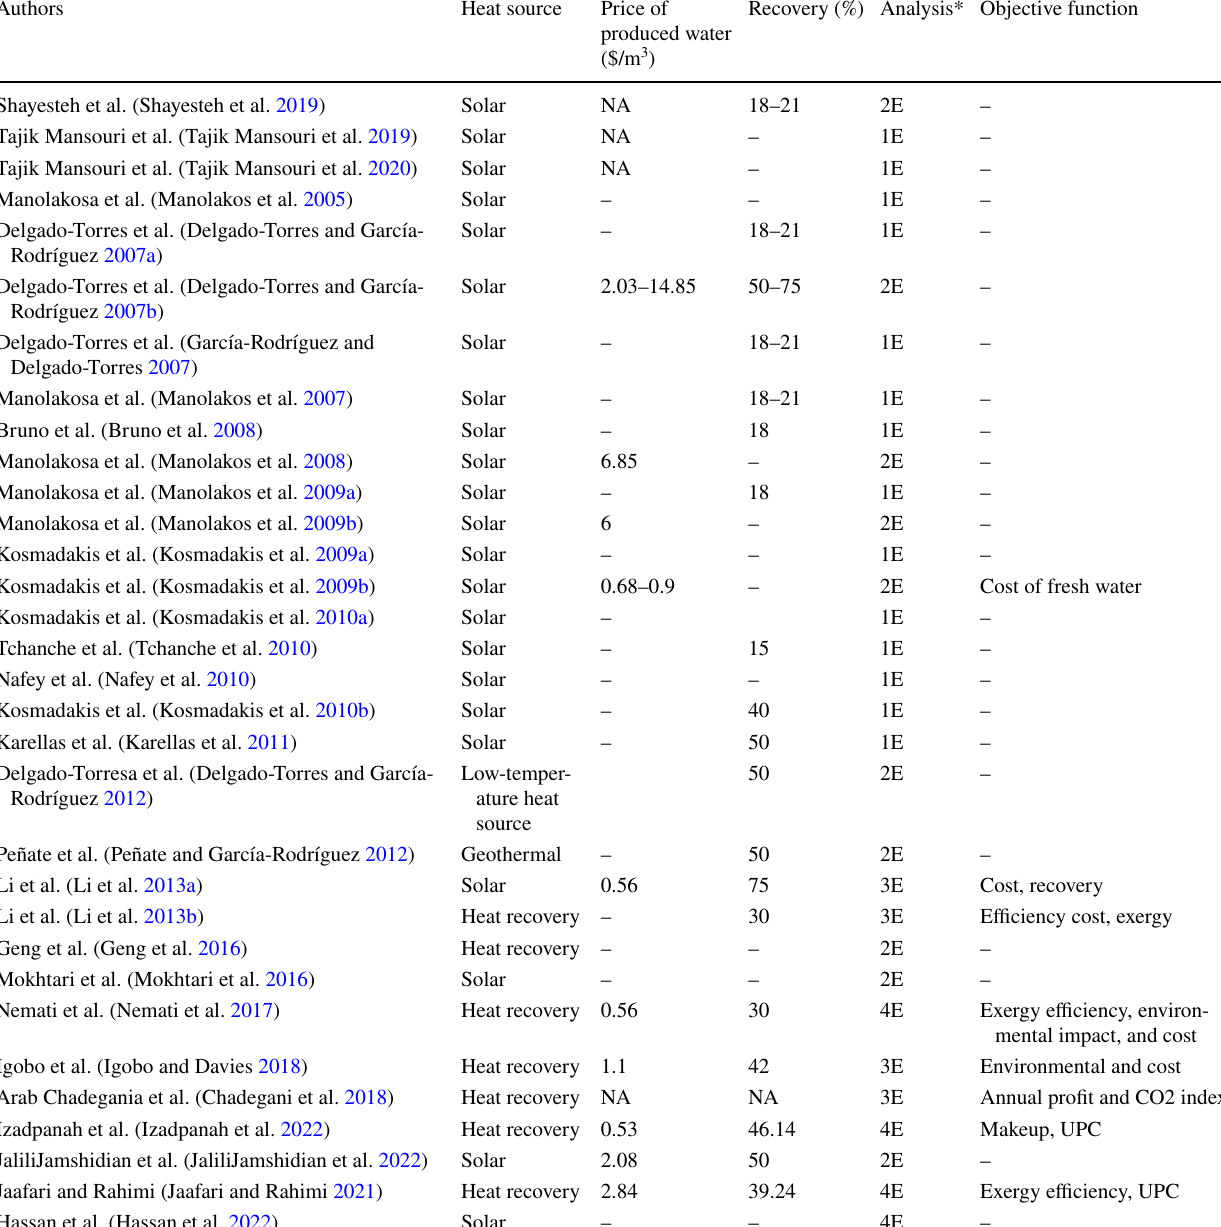
Table 2 Research on movers of RO system pumps from different heat sources